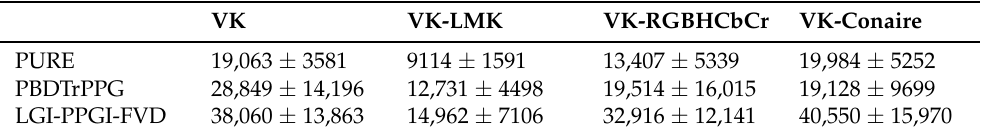
Table 2. ROI sizes (in pixels) expressed as a mean ± standard deviation for different image-processing front-ends and all studied data sets. VK: Viola-Jones combined with ROI width reduction and Kanade–Lucas–Tomasi tracker; VK-Conaire: Viola-Jones combined with skin detector based on the maximization of mutual information and Kanade–Lucas–Tomasi tracker; VK-LMK: Viola-Jones combined with landmarks detection and Kanade–Lucas–Tomasi tracker; VK-RGBHCbCr: Viola-Jones combined with RGB–H–CbCr skin-color segmentation and Kanade–Lucas–Tomasi tracker; FVP: Full Video Pulse Extraction rPPG algorithm. VK